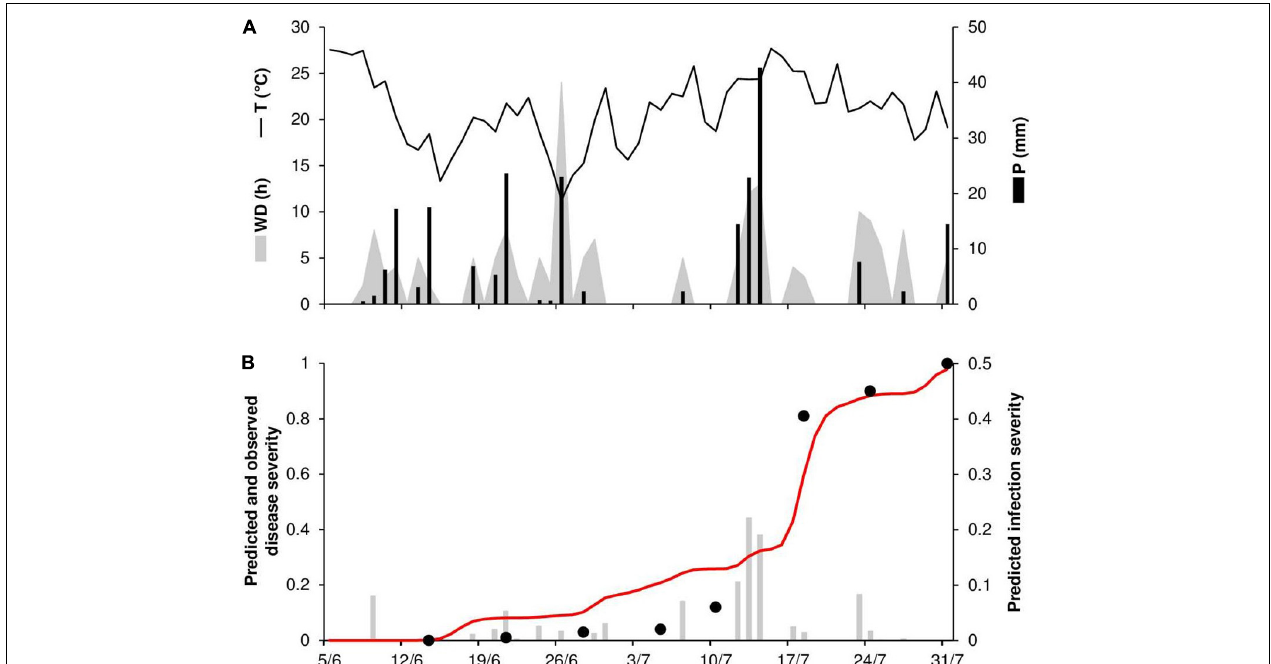
FIGURE 5 | Predicted and observed stem rust progress in the experimental wheat field (susceptible cv. Purdue 5481C-1-13-2) in Rosemount, MN, United States, in 1968 (ROS68). (A) Weather variables: air temperature (T, ◦ C, solid line), rainfall (R, mm, black bars), and wetness duration (WD, in h, gray area). (B) Infection severity predicted by the model (gray bars), disease severity predicted by the model (red line), and observed disease severity (full dots).